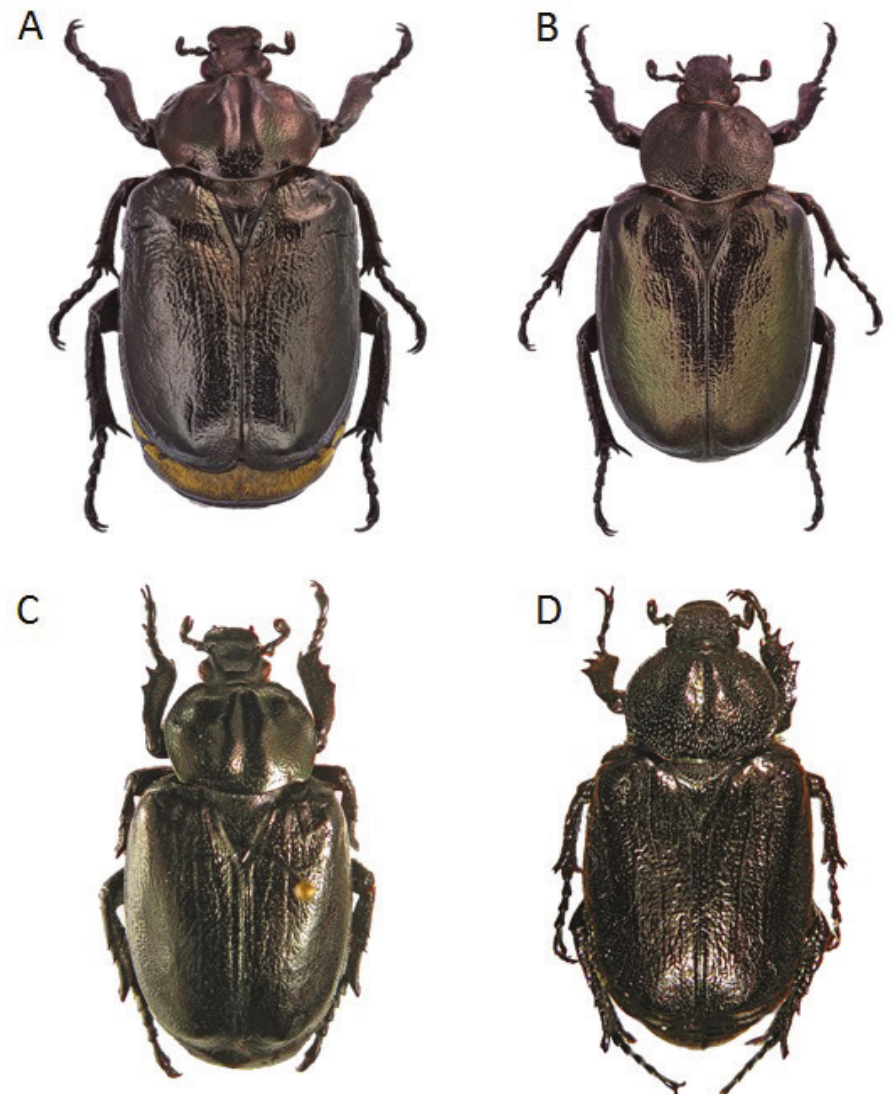
Figure 2. Habitus of Osmoderma in dorsal view. A O. eremita male B O. eremita female C O. cristinae male D O. cristinae female (photographs by A. Ballerio and M. Uliana, from Ballerio et al. 2010).